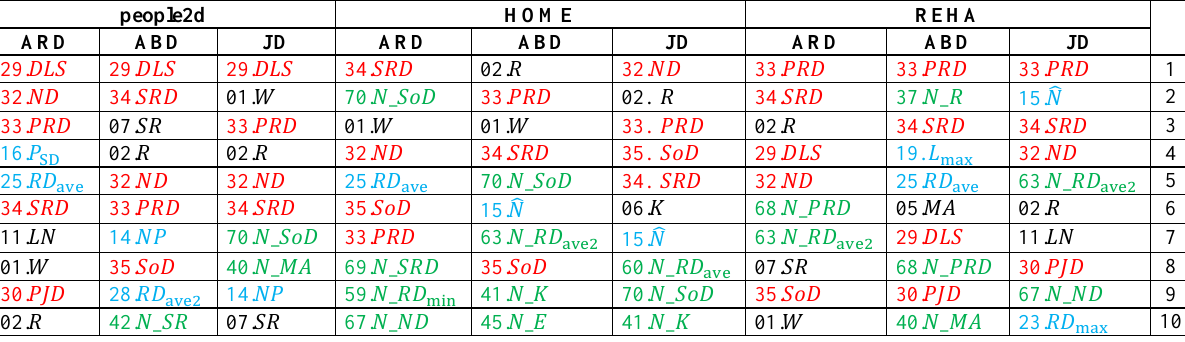
Table 10. Top 10 features in each strong classifiers of detector ALL where geometric features are in black, statistical features are in blue, spatial relationship features are in red and the nearest features are in